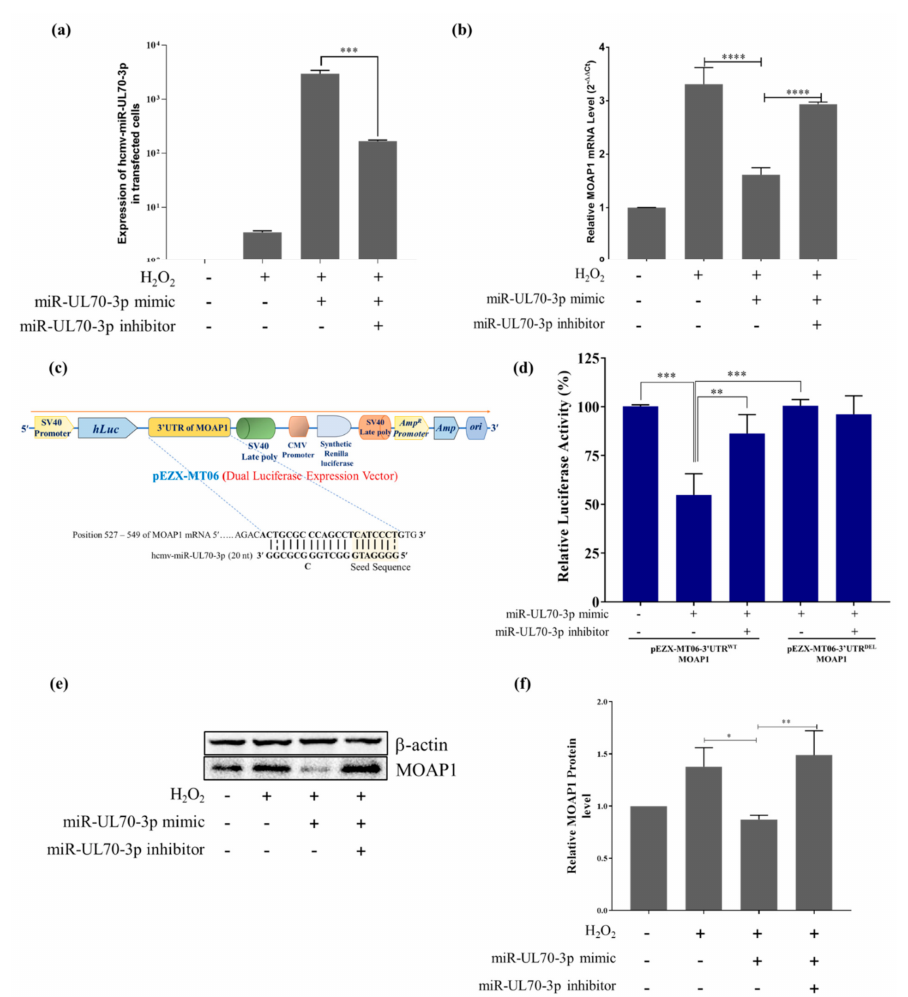
Figure 2. ( a ) Hcmv-miR-UL70-3p expression in the HEK293T cells post transfection with the hcmv- miR-UL70-3p mimic: The hcmv-miR-UL70-3p expression levels were measured in the cells post transfected with hcmv-miR-UL70-3p mimic. The quantity of hcmv-miR-UL70-3p levels was normal- ized to that of 5s rRNA in the corresponding samples. Data from three independent experiments were recorded and presented ( ± SEM; ***, p < 0.001). ( b ) Downregulation of MOAP1 mRNA by the ectopic expression of hcmv-miR-UL70-3p: The expression of MOAP1 mRNA in different experimental groups was determined by using qRT-PCR. The mRNA quantity of MOAP1 was normalized to that of GAPDH, and each sample was analyzed in triplicate. Results are expressed as the fold change (2 − ∆∆ Ct ) in treated groups relative to the control group ( ± SEM; ****, p < 0.0001). ( c ) Cartoon depicting the components of the pEZX-MT06 dual luciferase reporter vector having the 3 (cid:48) UTR of MOAP1, and the enlarged portion showing the binding position of hcmv-miR-UL70-3p in the 3 (cid:48) UTR of MOAP1. ( d ) Hcmv-miR-UL70-3p targeting the 3 (cid:48) UTR of MOAP1: Dual luciferase reporter assays were per- formed to test the interaction of hcmv-miR-UL70-3p to the 3 (cid:48) UTR of MOAP1 using pEZX-MT06- 3 (cid:48) UTR WT/DET -MOAP1 vector constructs. Data from three independent experiments were used for statistical analysis ( ± SEM; **, p < 0.01; ***, p < 0.001). ( e ) Hcmv-miR-UL70-3p downregulates the MOAP1 protein: The MOAP1 expression in the cells treated with or without hcmv-miR-UL70-3p, hcmv-miR-UL70-3p, and its inhibitor was detected by Western blotting. The bands of the blot have been cropped with no further manipulation. ( f ) The relative MOAP1 protein quantification was performed with ImageJ software, after normalizing with β -actin. Experiments were performed in triplicates (Supplementary Figure S2a), and the data from three different experiments were used for statistical analysis ( ± SEM; *, p < 0.05; **, p <